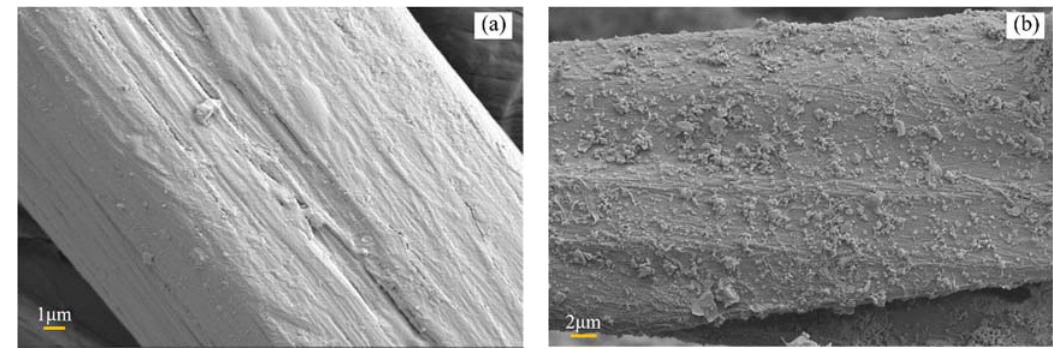
Figure 2. SEM photos of flax fiber: ( a ) untreated fiber ( b ) nano ‐ clay grafted fiber.